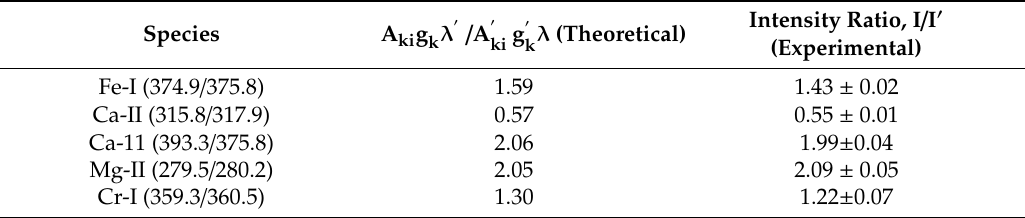
Table 2. Physical parameters required for the calculation of intensity ratios of the two atomic lines for di ff erent elements in the recorded spectra of the Dergaon